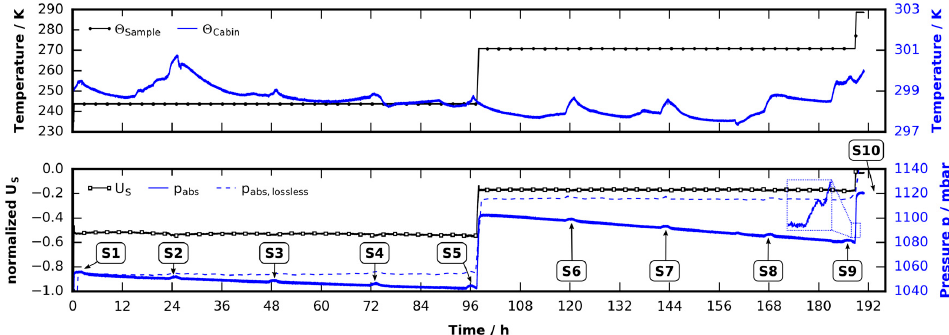
´ ¯ Θ Θ Figure 3. Sample and cabin temperature as well as cell pressure p abs and TEC Figure 3. Sample and cabin temperature (Θ (cid:2903)(cid:2911)(cid:2923)(cid:2926)(cid:2922)(cid:2915) ,Θ (cid:2887)(cid:2911)(cid:2912)(cid:2919)(cid:2924) ) as well as cell pressure (cid:1868) (cid:2911)(cid:2912)(cid:2929) and TEC Sample , Cabin supply voltage U S obtained during a long-term experiment with an ice sample. The pressure has supply voltage (cid:1847) (cid:2903) obtained during a long-term experiment with an ice sample. The pressure has Figure 3. Sample and cabin temperature (Θ (cid:2903)(cid:2911)(cid:2923)(cid:2926)(cid:2922)(cid:2915) ,Θ (cid:2887)(cid:2911)(cid:2912)(cid:2919)(cid:2924) ) as well as cell pressure (cid:1868) (cid:2911)(cid:2912)(cid:2929) and TEC been corrected and normalized to a hypothetically constant cabin temperature (see Section 4.4.2). been corrected and normalized to a hypothetically constant cabin temperature (see Section 4.4.2). The supply voltage (cid:1847) (cid:2903) obtained during a long-term experiment with an ice sample. The pressure has The markers S1–S10 indicate a series of consecutive µ CT scans. The continuous decrease in pressure is markers S1–S10 indicate a series of consecutive µCT scans. The continuous decrease in pressure is been corrected and normalized to a hypothetically constant cabin temperature (see Section 4.4.2). The markers S1–S10 indicate a series of consecutive µCT scans. The continuous decrease in pressure is due to diffusion of gas across the silicone O-ring. (cid:1868) (cid:2911)(cid:2912)(cid:2929),(cid:2922)(cid:2925)(cid:2929)(cid:2929)(cid:2922)(cid:2915)(cid:2929)(cid:2929) shows the pressure in a lossless cell, due to diffusion of gas across the silicone O-ring. p abs,lossless shows the pressure in a lossless cell, which . due to diffusion of gas across the silicone O-ring. (cid:1868) (cid:2911)(cid:2912)(cid:2929),(cid:2922)(cid:2925)(cid:2929)(cid:2929)(cid:2922)(cid:2915)(cid:2929)(cid:2929) shows the pressure in a lossless cell, which is obtained by subtracting an integrated pressure loss rate (cid:1868)(cid:4662) (cid:2922)(cid:2925)(cid:2929)(cid:2929) from (cid:1868) (cid:2911)(cid:2912)(cid:2929) . Small bumps in p is obtained by subtracting an integrated pressure loss rate from p abs . Small bumps in pressure, loss which is obtained by subtracting an integrated pressure loss rate (cid:1868)(cid:4662) (cid:2922)(cid:2925)(cid:2929)(cid:2929) from (cid:1868) (cid:2911)(cid:2912)(cid:2929) . Small bumps in pressure, which correspond to an increase in cell temperature are seen in each scan. This increase in which correspond to an increase in cell temperature are seen in each scan. This increase in temperature pressure, which correspond to an increase in cell temperature are seen in each scan. This increase in temperature of approximately 0.5 K is caused by energy deposited by the X-rays. The inset at the far of approximately 0.5 K is caused by energy deposited by the X-rays. The inset at the far right shows a temperature of approximately 0.5 K is caused by energy deposited by the X-rays. The inset at the far right shows a zoom into the pressure signal at the melting point of ice. zoom into the pressure signal at the melting point of ice. right shows a zoom into the pressure signal at the melting point of ice.